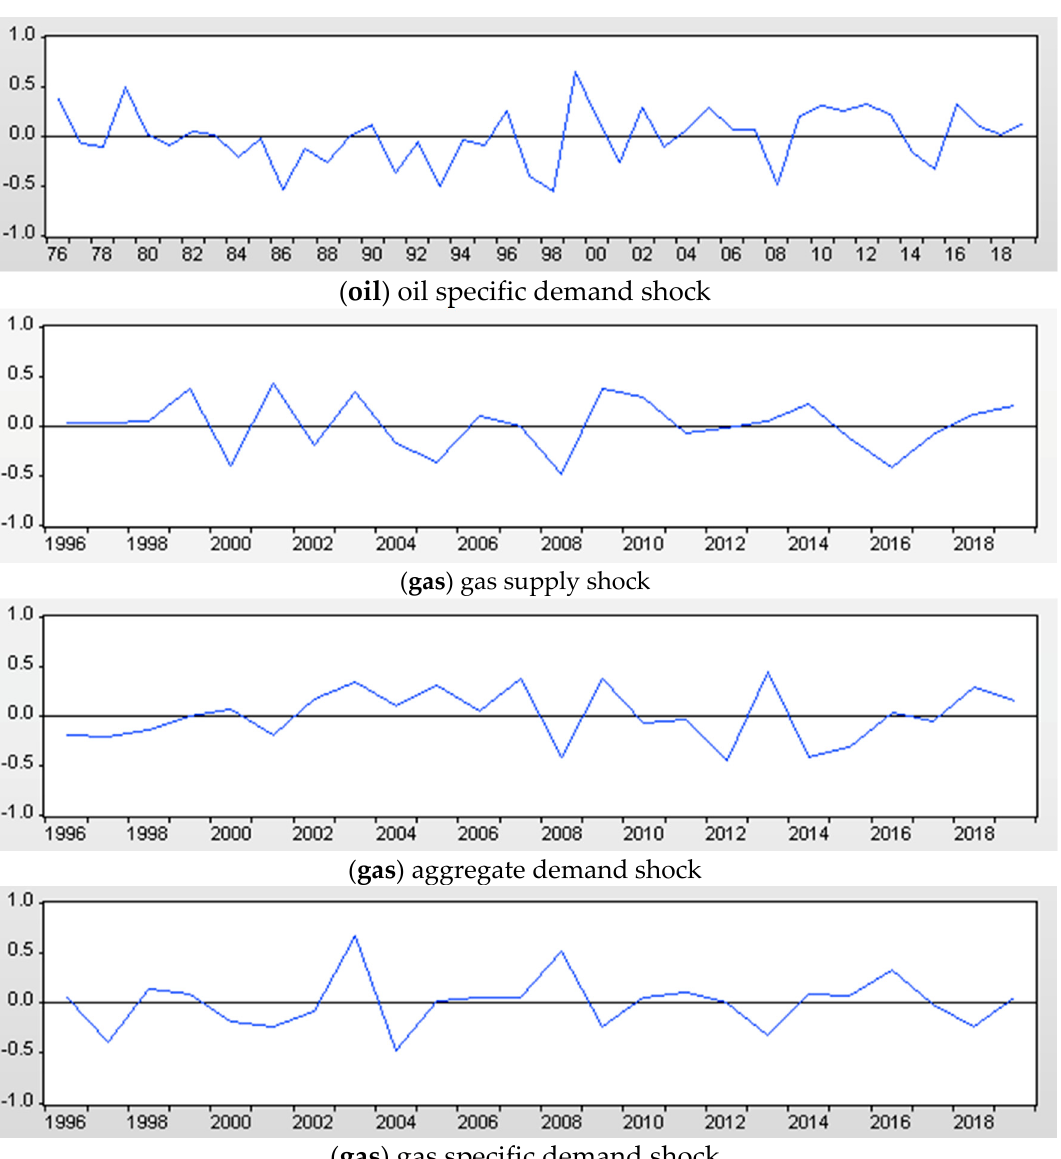
Figure 1. Historical evolution of structural shocks. From top to bottom, column ( oil ) illustrates crude oil supply, aggregate demand, and oil-specific demand shocks from 1976 to 2019. From top to bottom, column ( gas ) illustrates natural gas supply, aggregate demand, and gas-specific demand shocks from 1996 to 2019. Note: Structural residuals implied by Equations (1)–(4), averaged annually.